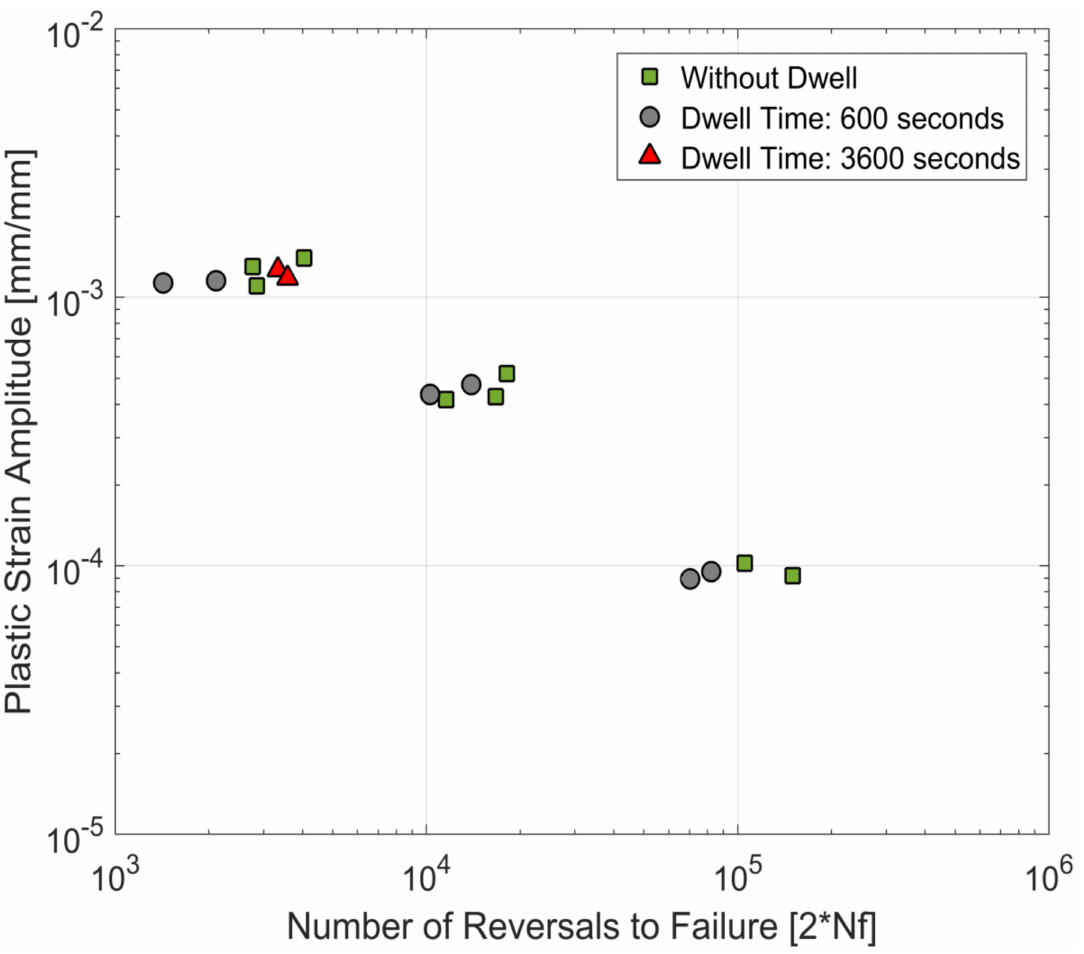
Figure 17. Strain life curves at 150 ◦ C—comparison of fatigue tests with and without compressive dwell